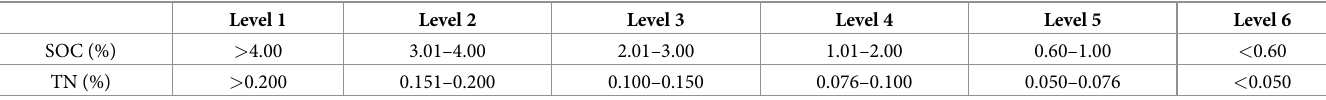
Soil C, N contents were divided into six levels from level 1 to level 6 according to the national classification standard for soil nutrient content [28] (Table 3). According to the K-S test, soil C, N contents and C:N ratio in the 1980s and the 2010s were accords with the normal distribu- tion. Based on the optimal semi-variogram models, the ordinary Kriging method was used to predict the spatial distribution of soil nutrient elements in the study area. Fig 2 shows the vari- ation of soil C, N contents and C:N ratio from the 1980s to the 2010s in the major grain-pro- ducing regions of North China Plain, and the area of different levels of C, N contents and C:N ratio was calculated by using the spatial analysis function of ArcGIS 10.2 (Fig 3). Table 3. National classification standard for soil nutrient content